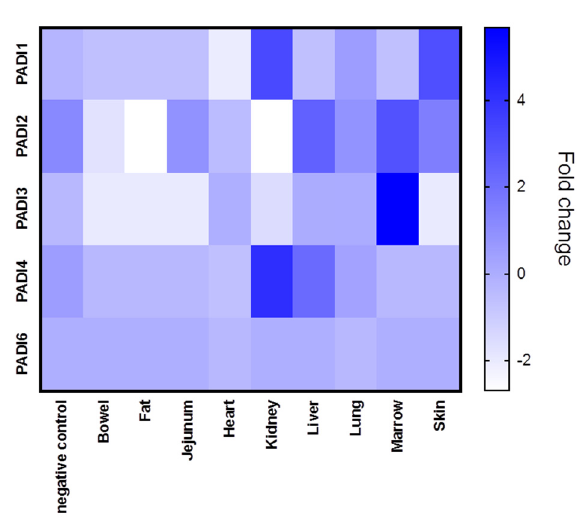
Figure 1. PRJNA631753 samples were analysed according to fold-change for PADI1, PADI2, PADI3, PADI4 and PADI6 mRNA levels. Average data from different tissue types are presented with a heat map. Lung and heart samples were from 5 different cases, alongside normal lung samples (“negative control”), with at least 3 replicate biopsy results. The bowel, kidney and liver data were from 2 cases. The data given for fat, jejunum, marrow and skin tissues were from one case. Heat map metric is given as blue bar between normalised mRNA levels.